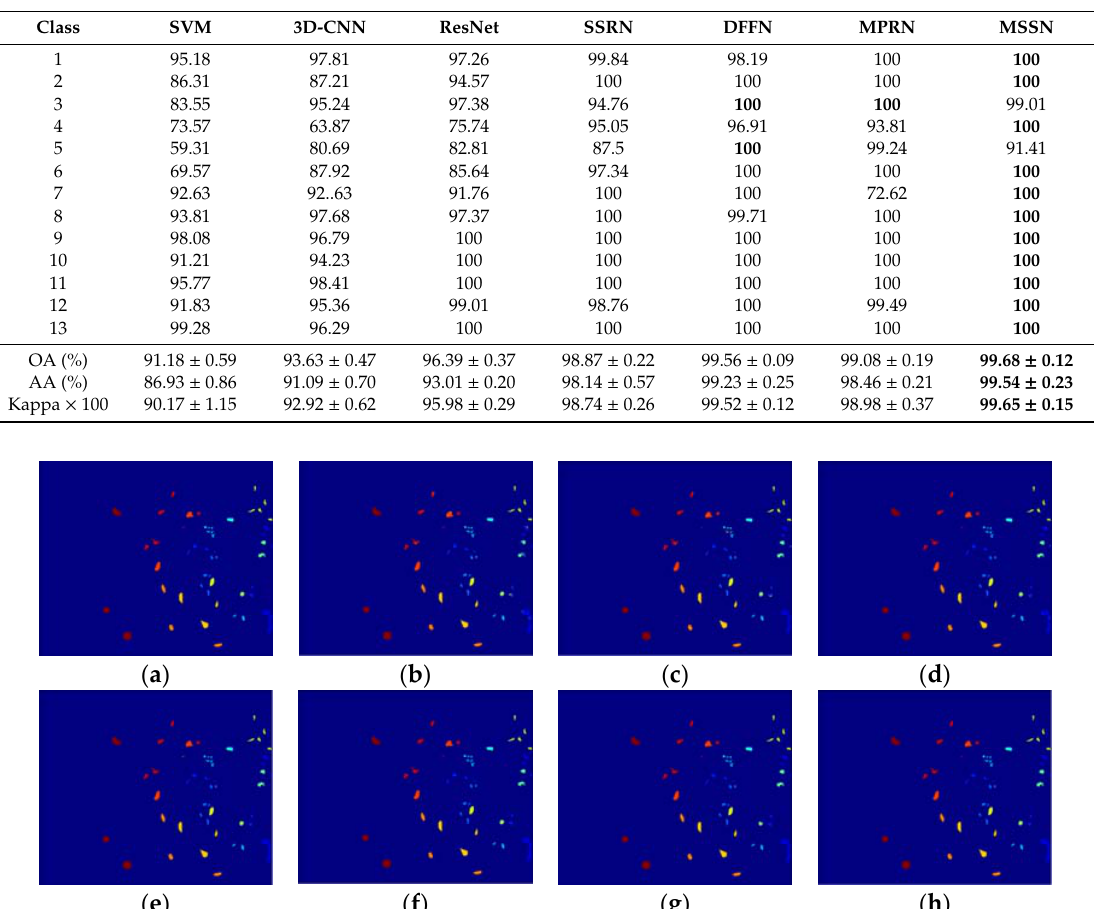
Table 7. Classification results obtained by di ff erent methods on the KSC data set. Data are given as mean ± standard deviation.